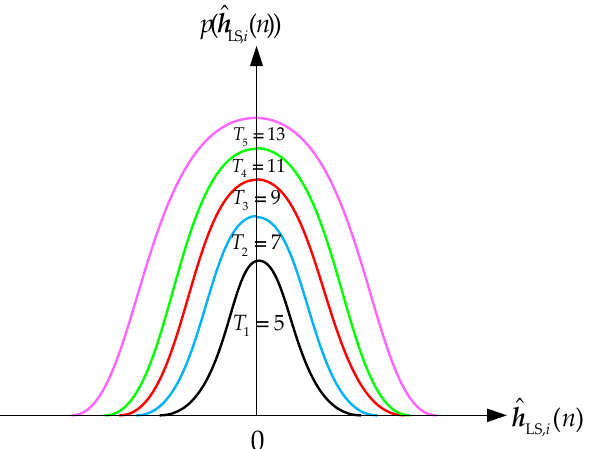
Figure 2. The probability distribution function of the Gaussian distribution of noise under different statistical frames.